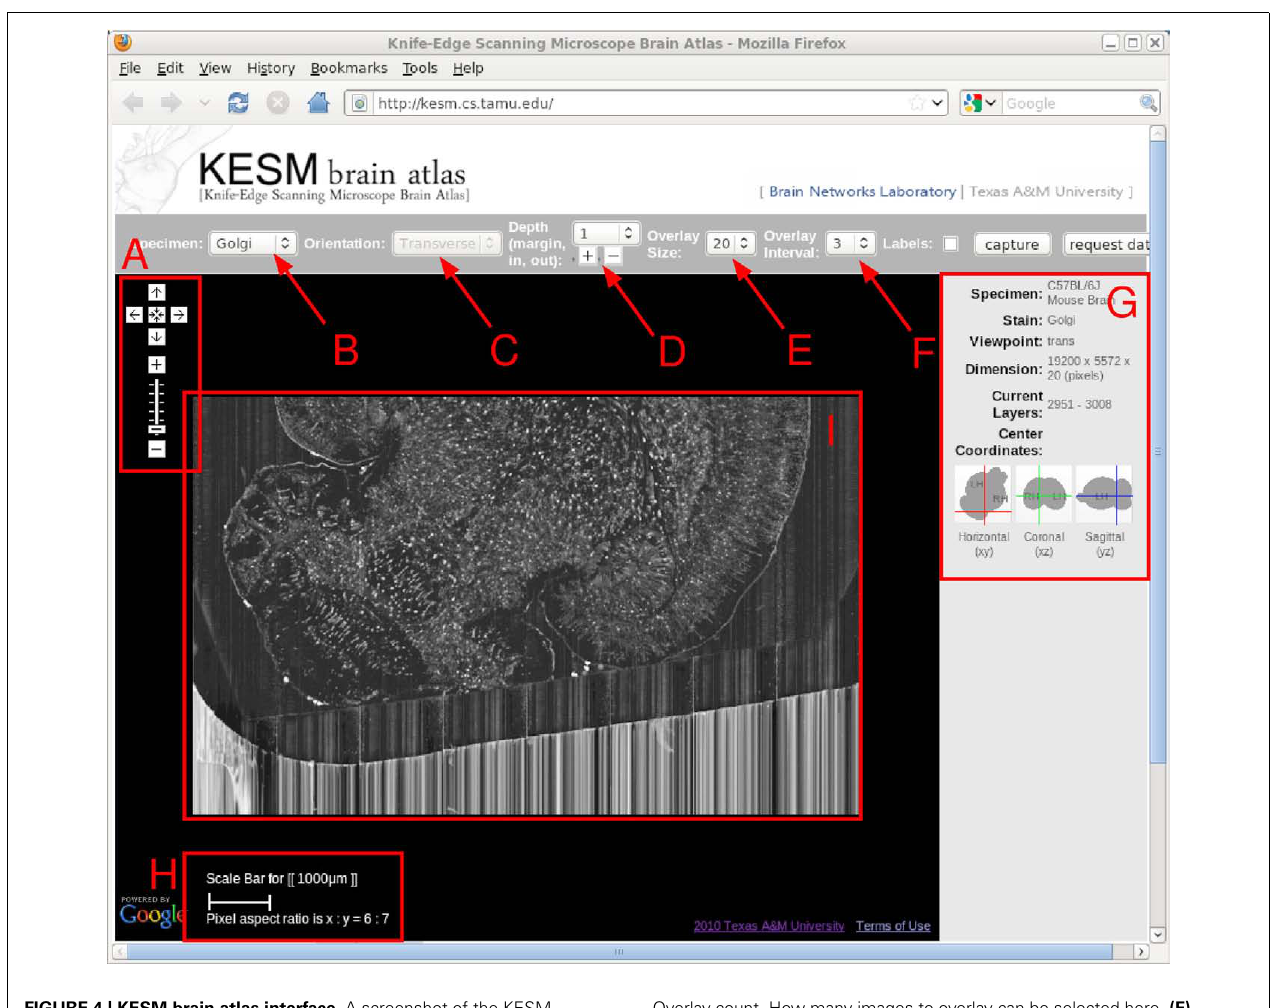
FIGURE 4 | KESM brain atlas interface. A screenshot of the KESM brain atlas running in a web browser is shown. Red markers and text were added on top for the purpose of explanation, below. (A) Navigation panel: panning and zoom-in/zoom-out. (B) Data set selection. Golgi, Golgi2, India Ink are available in the pull-down menu. (C) Sectioning plane orientation.Three standard planes supported (planned). (D) Depth navigation. Amount of movement (unit = 1 μ m) in the z direction and forward (deeper, [ + ]) or backward (shallower, [ − ]) can be controlled. (E)